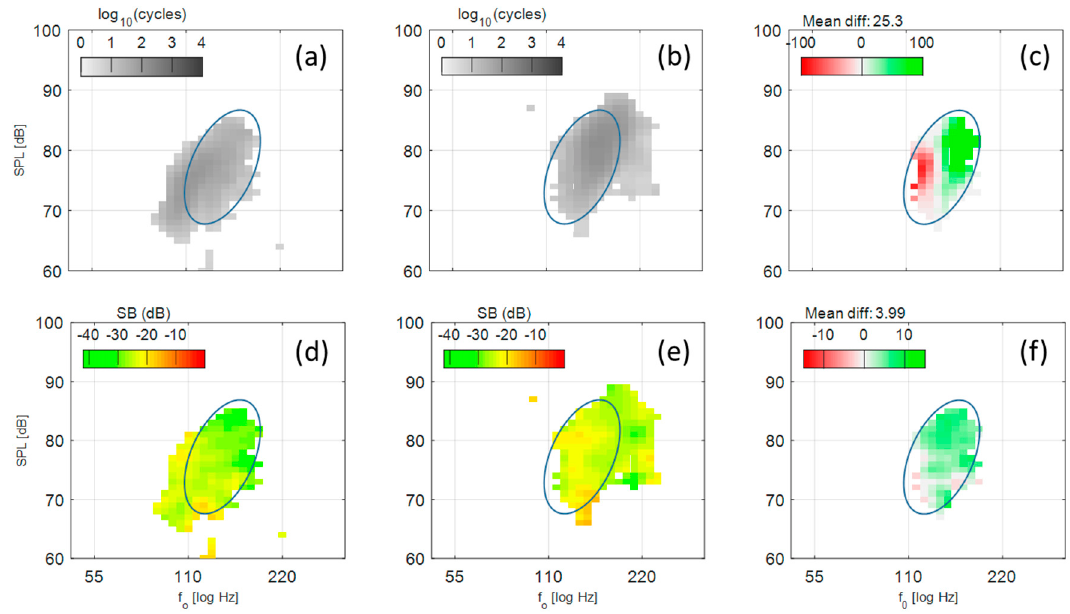
Figure 5. Examples of maps across an intervention. A patient read for two minutes from The North Wind and the Sun , in Swedish, before and after feminization therapy. Top row: the density, i.e., the number of cycles phonated ( a ) before therapy, ( b ) after therapy, and ( c ) the difference. Bottom row, the spectrum balance SB (level > 2 kHz – level < 1.5 kHz), ( d ) before therapy, ( e ) after therapy, and ( f ) the difference in the overlapping region. The ovals approximating the overlap region are all in the same place, given for visual reference only. In that region, each cell contained an average count of 22 phonatory cycles. After therapy ( f ), the mean SB had increased by 4 dB in the region of the voice range that was visited both pre- and post-intervention.